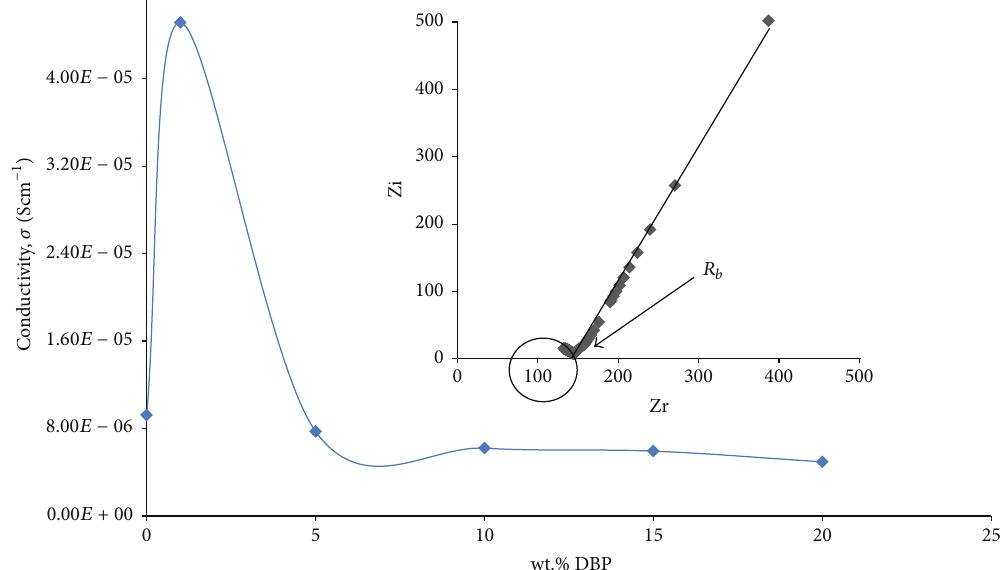
Figure 3: Ionic conductivities of SPE for various wt.% of DBP and impedance plot for sample with the highest conductivity (inset).